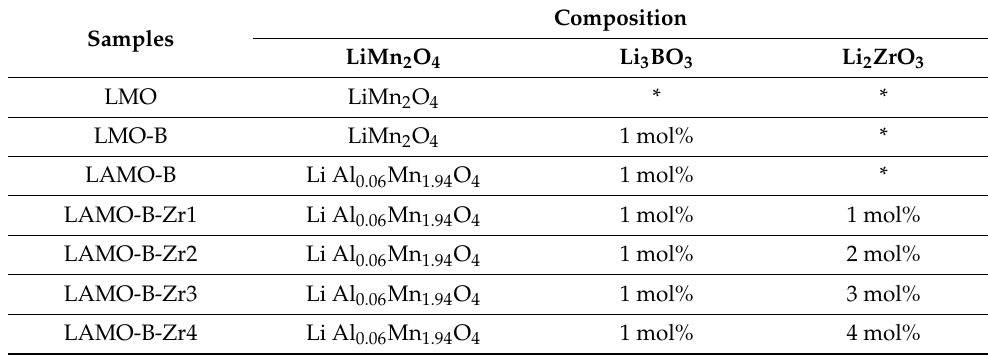
Table 1. Specific component of the micron-sized monocrystalline LiMn 2 O 4 samples (* No